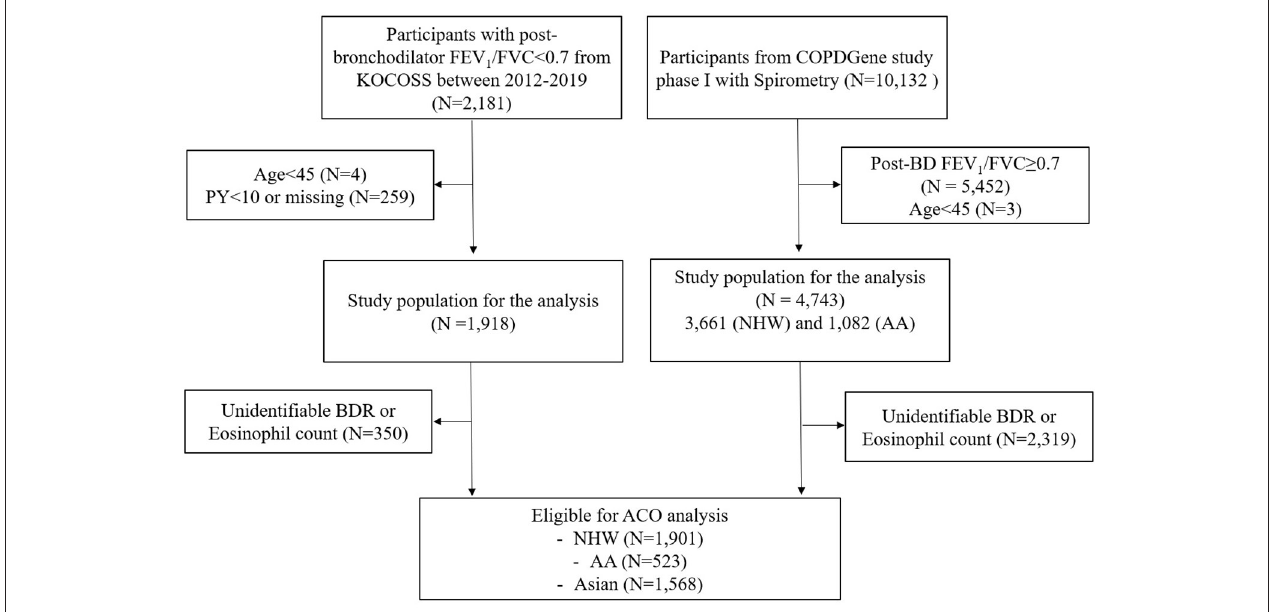
FIGURE 1 | Flow diagram of the subjects in two cohorts. AA, African American; ACO, asthma–chronic obstructive pulmonary disease (COPD) overlap; BDR, bronchodilator response; COPD, chronic obstructive pulmonary disease; FEV 1 , forced expiratory volume in 1s; FVC, forced vital capacity; KOCOSS, The Korean COPD Subgroup Study; NHW, non-Hispanic white; PY,